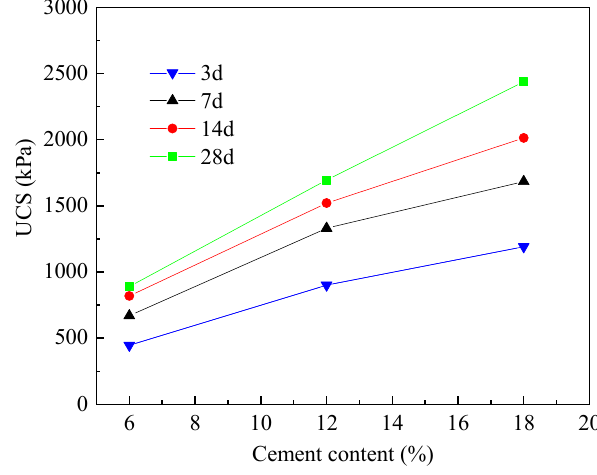
Figure 8. Correlation between the UCS and cement content.